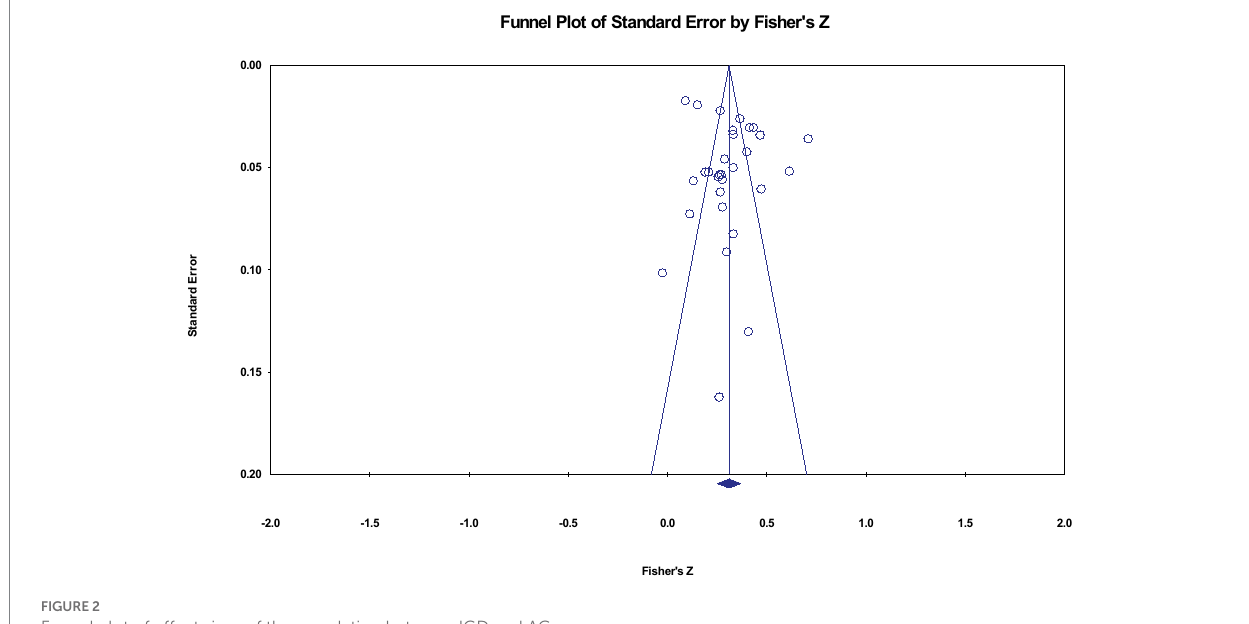
FIGURE 2 Funnel plot of effect sizes of the correlation between IGD and